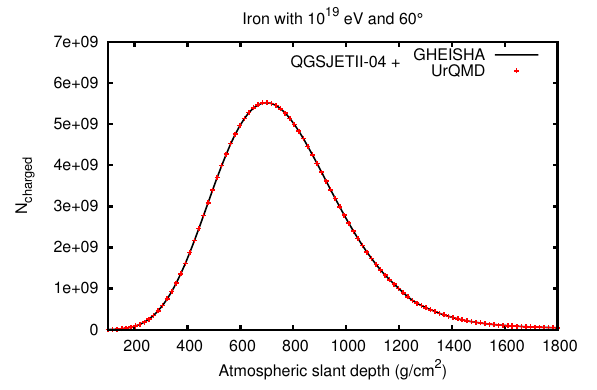
Figure 2. Energy deposit in air given by QGSJETII-04 alter- natively combined with low energy hadronic interaction mod- els GHEISHA and UrQMD, for an incoming primary iron with E = 10 19 eV and θ = 60 ◦ .